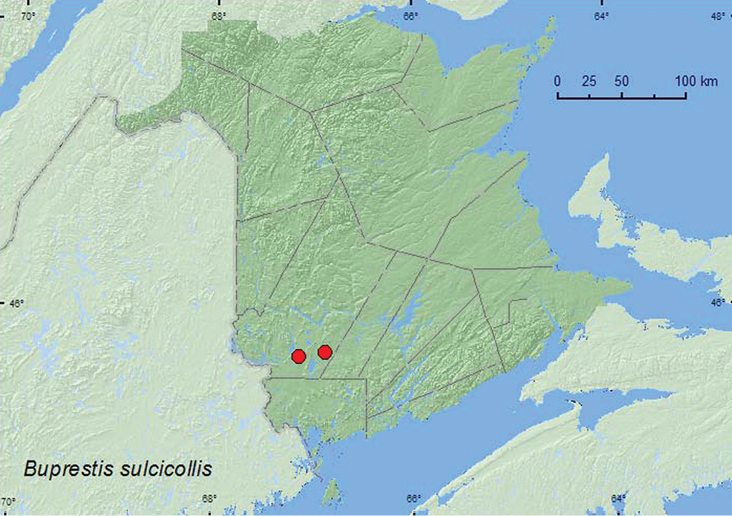
Collection localities in New Brunswick, Canada of Buprestis sulcicollis.